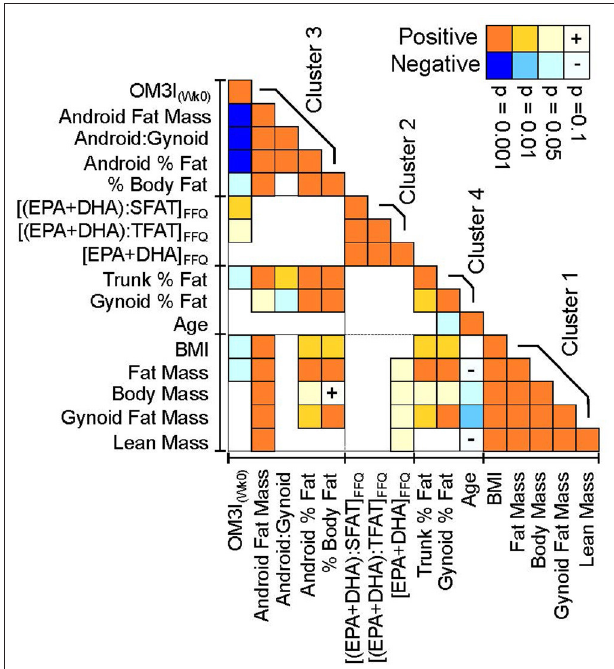
FIGURE 5 | Pearson’s correlation heatmap of the baseline omega-3 index, habitual omega-3 fatty acid factors and DXA-dependent body composition measures. Correlation statistics are calculated on normally transformed data, with positive (orange) and negative (blue) correlation strength indicated by color intensity. Variables were clustered in JMP v16 using implementation of the SAS VARCLUS algorithm. Clusters are ranked by decreasing order of explained variance. Variables are ordered within clusters by their correlation strength with the baseline omega-3 index (OM3I (Wk0) ). FFQ, food frequency questionnaire; SFAT, dietary saturated fat; TFAT, dietary total